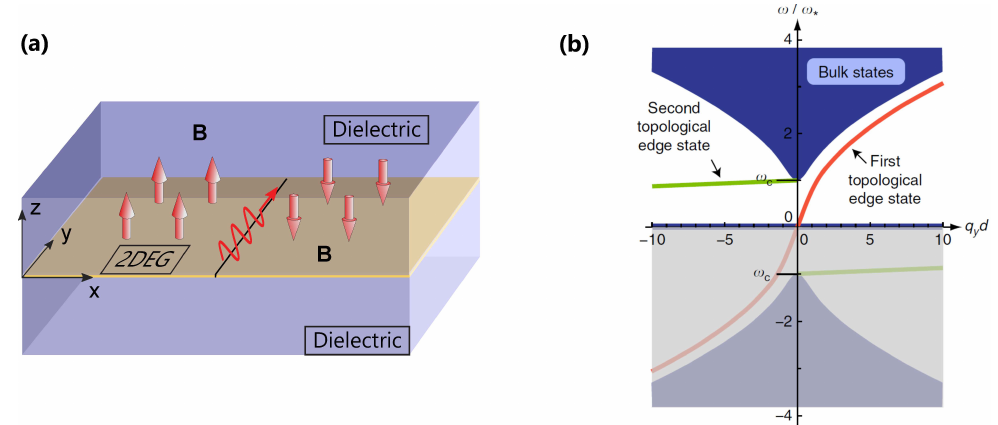
Figure 8. Unidirectional edge modes at the interface between two 2DEGs with oppositely directed external magnetic bias. ( a ) Geometry of the structure. ( b ) Bulk-mode and edge-mode dispersion diagram. Two edge modes propagating in the same direction (same sign of group velocity) are present in the bulk-mode bandgap. Since the gap Chern number for a single magnetized 2DEG is ± 1, the gap Chern number difference for the common bandgaps in this system is ± 2, correctly predicting the net number of unidirectional edge modes according to the bulk-edge correspondence principle. ( b ) reproduced with permission from